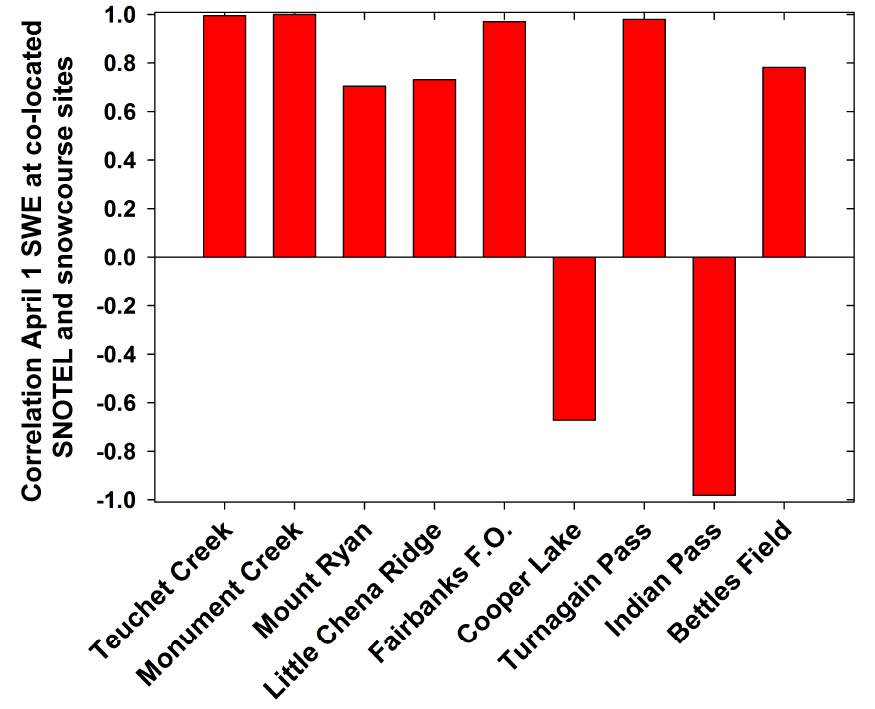
Figure 2. Correlation (Pearson) between the April 1 SWE measured over at least three decades at co-located SNOTEL and snowcourse sites. Teuchet Creek through Fairbanks F.O. are in the northwest part of Alaska Division 5; Cooper Lake though Indian Pass are in southern Alaska Division 6; Bettles Field is in Division 3.